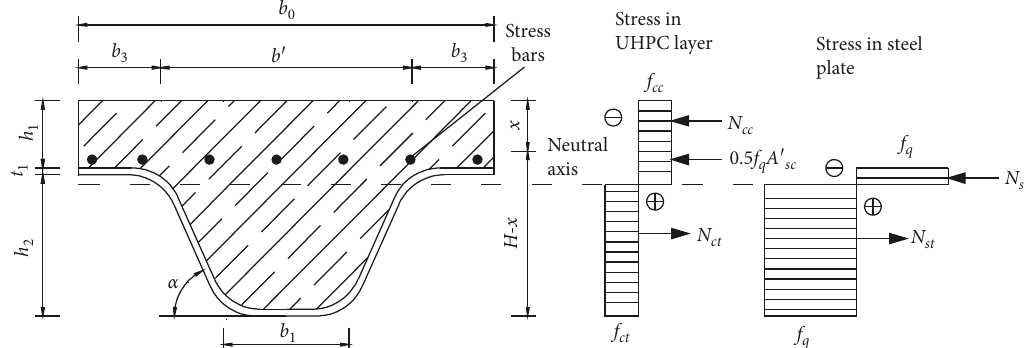
Figure 2: Bending performance of the corrugated steel plate-UHPC composite bridge deck (scenario